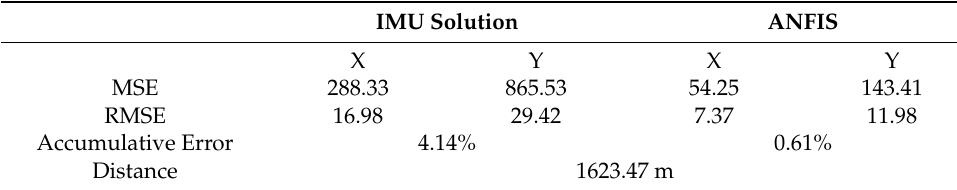
Figure 8. Error accumulation curve of two algorithms: ( a ) X-direction position error; ( b ) Y-direction position error. Table 6. Error statistics of two algorithms.